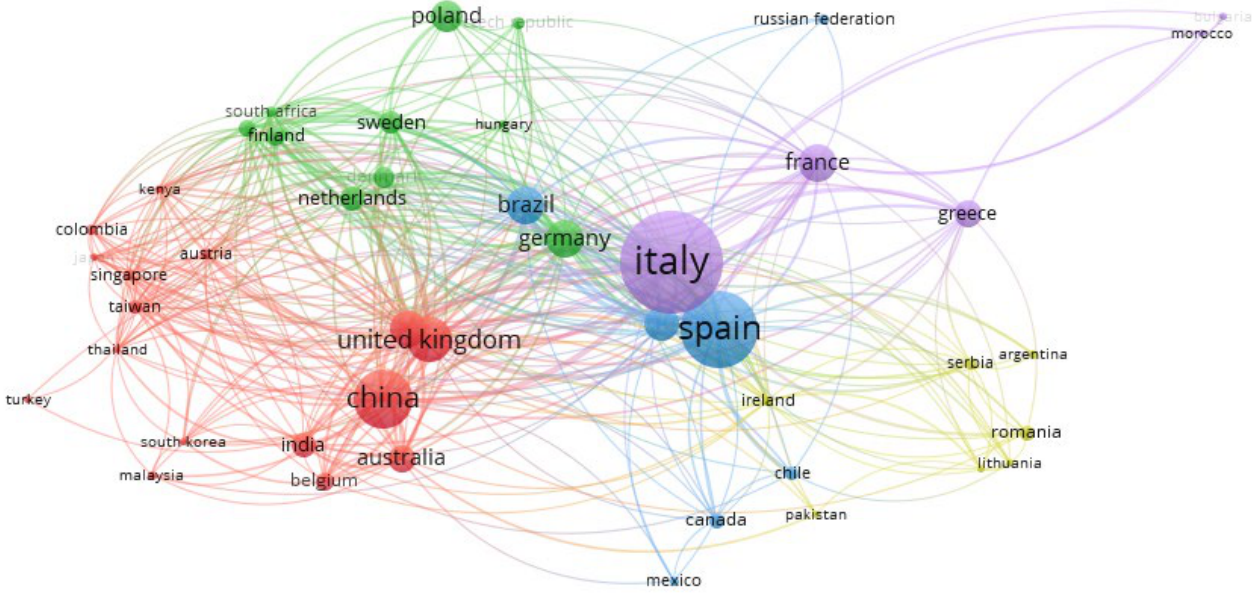
Figure 5. International cooperation based on co-authorship between countries (2005–2021).